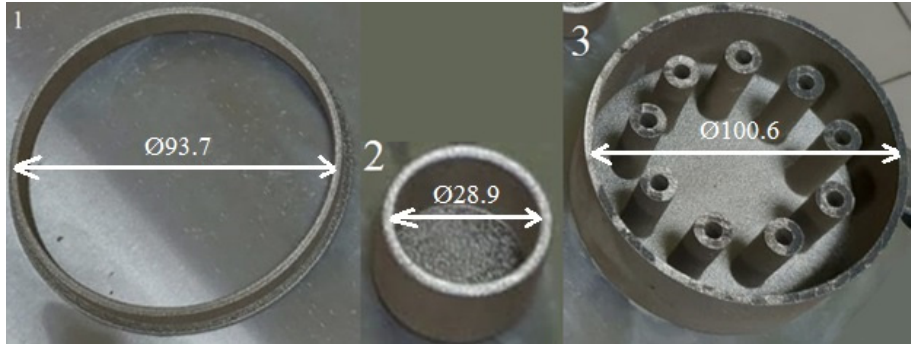
Figure 9. Tooling: 1—external cover, 2—inner cover and 3—casing.